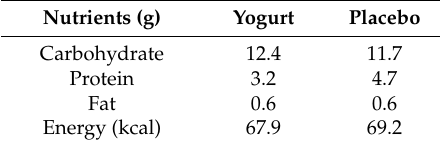
Table 1. Composition of the 100 mL of test drinks.